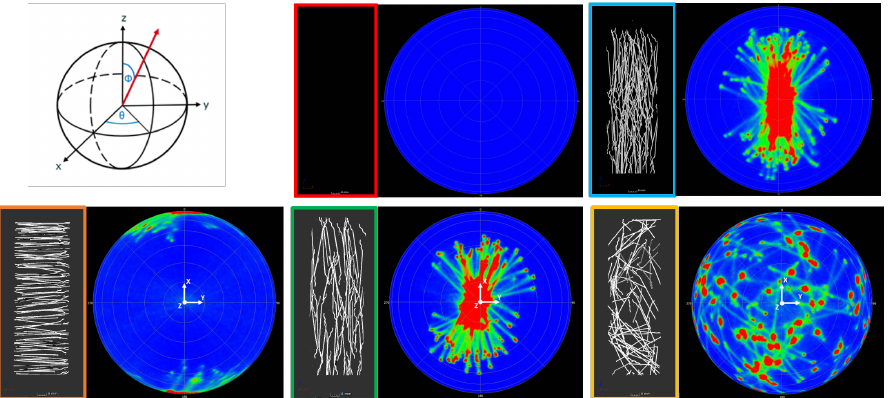
Figure 7. Spherical coordinate system , reproduced from Oesch et al. 2018 under the terms of the Creative Commons Attribution 4.0 International License (https://creativecommons.org/licenses/ by/4.0/, accessed on 28 November 2021), ( top left ) ). Fiber renderings and orientation histograms for sample Q0F Cylinder ( top centre ), Q80 ||| Cylinder ( top right ), Q40—Cylinder ( bottom left ), Q40 ||| Cylinder ( bottom centre ), Q40* Cylinder ( bottom right ). Histogram radius: 0 < Φ < 90 ◦ ; histogram circumference: 0 < Θ < 360 ◦